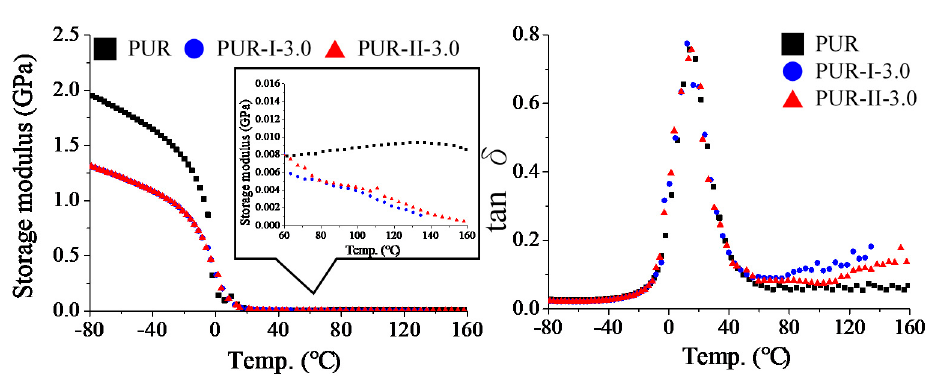
Figure 6. Dynamic mechanical analyzer (DMA) analysis of various cured PUR.